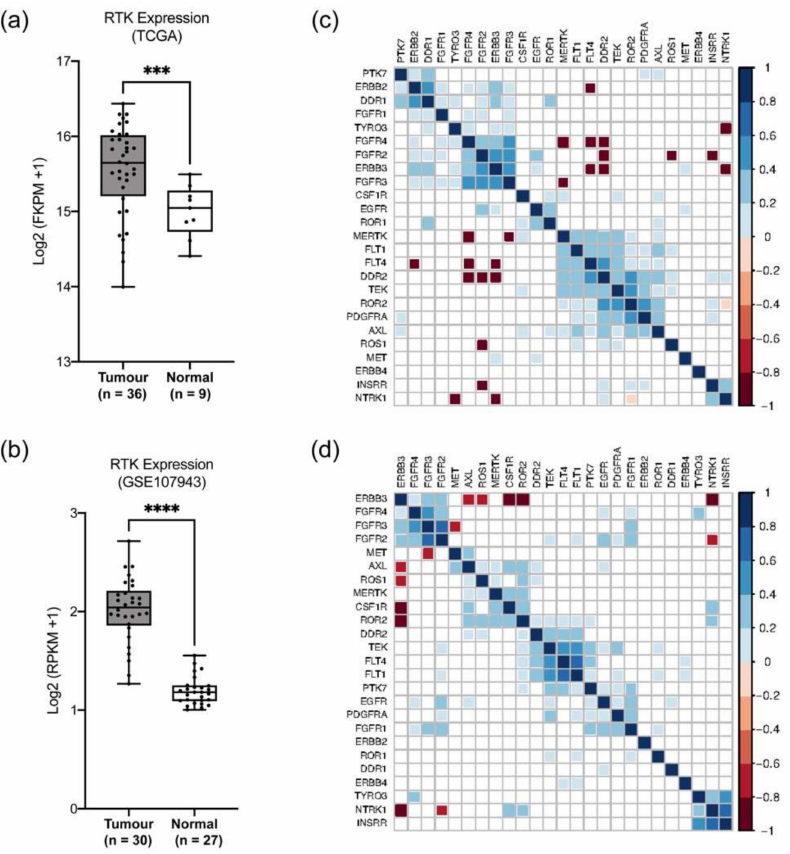
Figure 5. Validation of RTK25 in two independent RNA-seq databases. Boxplots represent the median value of averaged gene expression of RTK25 in CCA and normal tissues in ( a ) The Cancer Genome Atlas-Cholangiocarcinoma (TCGA-CHOL) and ( b ) GSE107943. ‘ n ’ refers to the number of samples in each group. The method for differential analysis between tumor and normal was one-way ANOVA testing followed by Holm–Sidak post-hoc analysis (*** p < 0.001, **** p < 0.0001). Correlation matrix represents significant Pearson correlation coefficients in ( c ) TCGA-CHOL and ( d ) GSE107943. Color indicates correlation (blue, positive correlation ( r = 0 to 1); red, negative correlation ( r = − 1 to 0)). Area of the square indicates the value of corresponding Pearson’s correlation coefficients. FKPM: fragments per kilobase million; RPKM: reads per kilobase